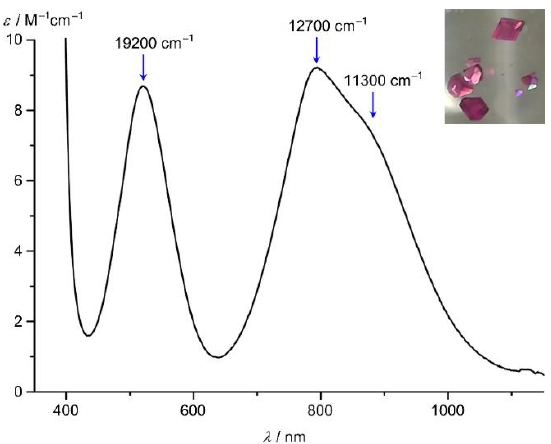
Figure 5. UV/Vis/NIR spectrum of [Ni(ddpd) 2 ][BF 4 ] 2 in CH 3 CN; ligand field bands and the spin-flip band indicated by blue arrows; photograph of crystals of [Ni(ddpd) 2 ][BF 4 ] 2